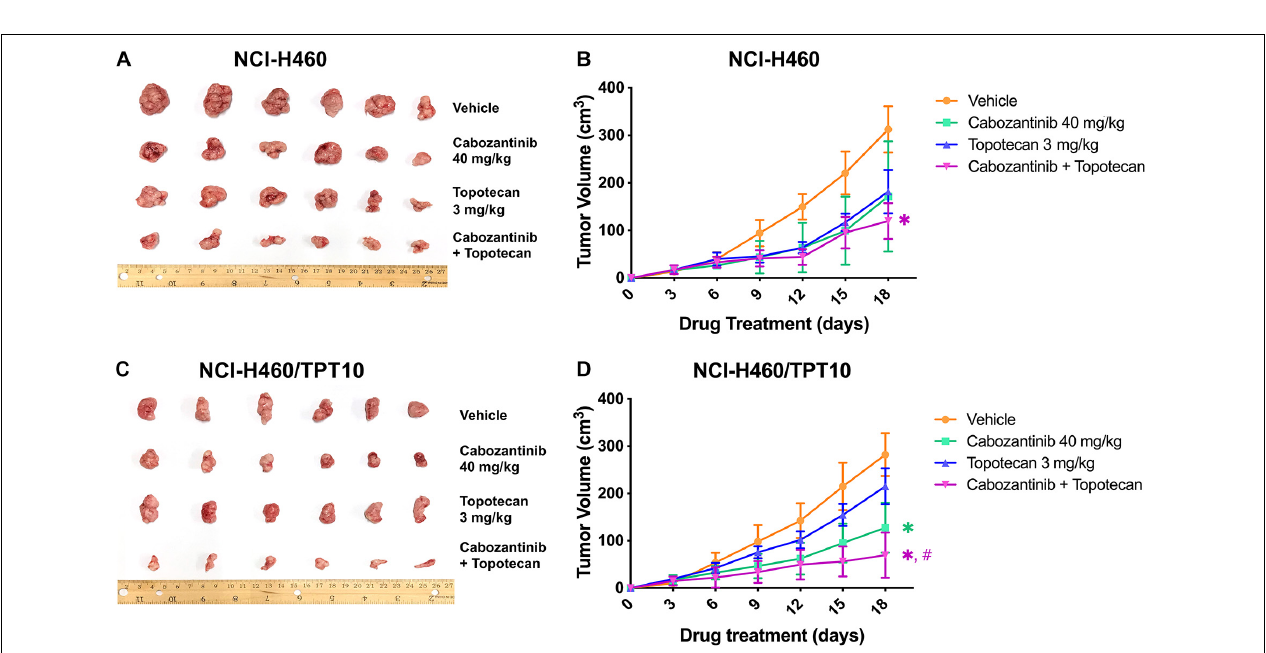
FIGURE 3 | Effect of cabozantinib combined with topotecan on the expression of ABCG2 and topoisomerase I (TOP1). Expression of ABCG2 protein (A) and TOP1 protein (B) in H460 and H460/TPT10 cell lines treated for 72 h with vehicle control, topotecan (TPT) 30 nM, cabozantinib (CBZ) 5 µ M, and combination of topotecan and cabozantinib, respectively, followed by the quantitative analysis. For ABCG2 expression, an imaged obtained with extended exposure time was shown as evidence for the endogenous ABCG2 expression in NCI-H460 cells and was not for quantitative use. The relative protein expression was calculated based on the ratio of target protein versus the loading control protein GAPDH. Columns and error bars represented average values with SD from three independent measurements. ∗ indicates p < 0.05 comparing resistant cell line to parental cell line with the same treatment; # indicates p < 0.05 comparing treatment group to control group of the corresponding cell line.